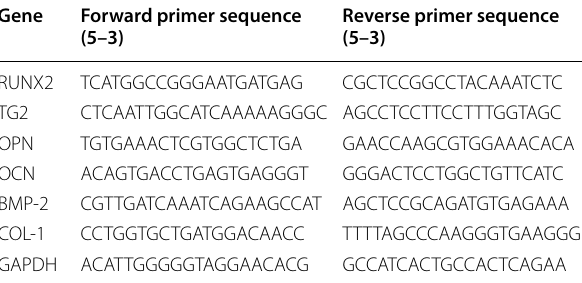
Table 1 Primers used for quantitative reverse transcription polymerase chain reaction Gene Forward primer sequence (5–3)